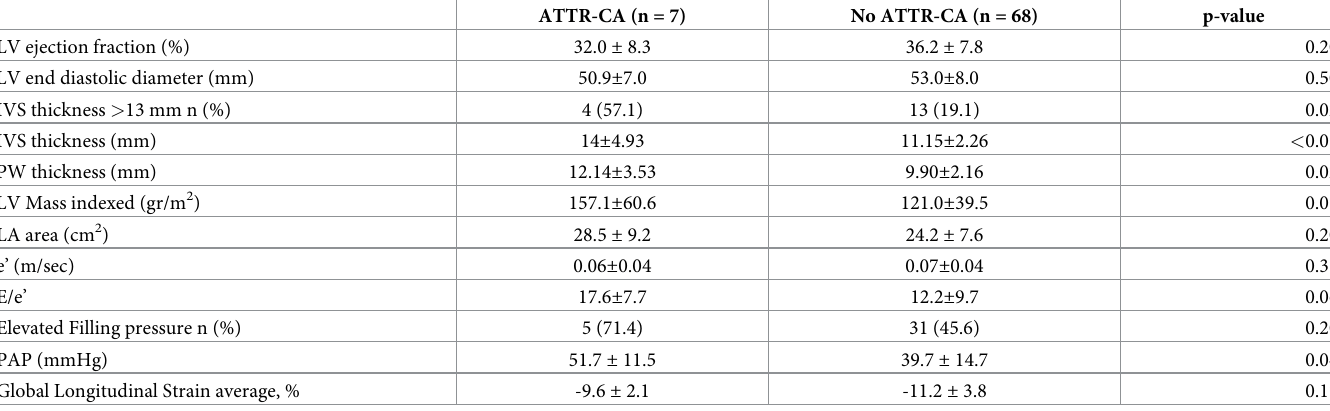
Table 2. Comparison of echocardiographic measures between patents with and without ATTR-CA.